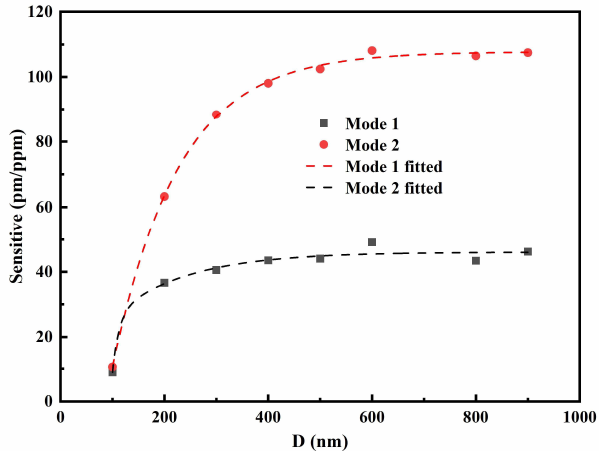
Figure 5. CO 2 concentration sensitivity varies as a function of PHMB thickness (D). To unveil the behind physics, the electric field distributions of mode 1 and mode 2 in different planes when PMHB thickness is 200 nm and 900 nm are shown in Figure 6. When the metasurface is covered by a PHMB layer, the light energy of the extended mode (mode 2, Figure 6h,i,k,l) spreads to the high refractive index gas-trapping layer, resulting in sufficient interaction with the surroundings. Nevertheless, most near fields of the confined mode (mode 1, Figure 6b,c,e,f) are still concentrated tightly inside the resonator. Accordingly, the RI sensitivity of mode 2 is much higher than mode 1.